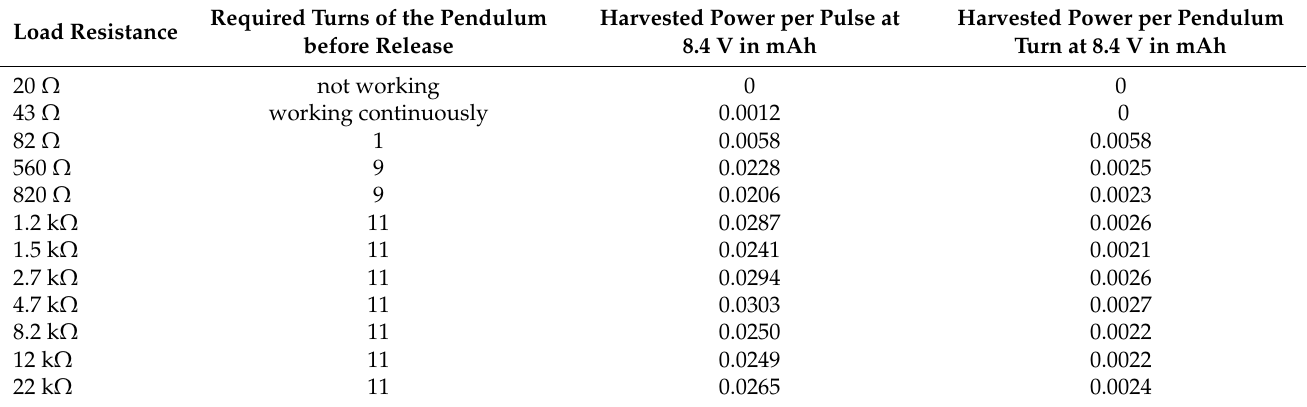
Table 5. Characterization of the converter voltage output under different load resistances.